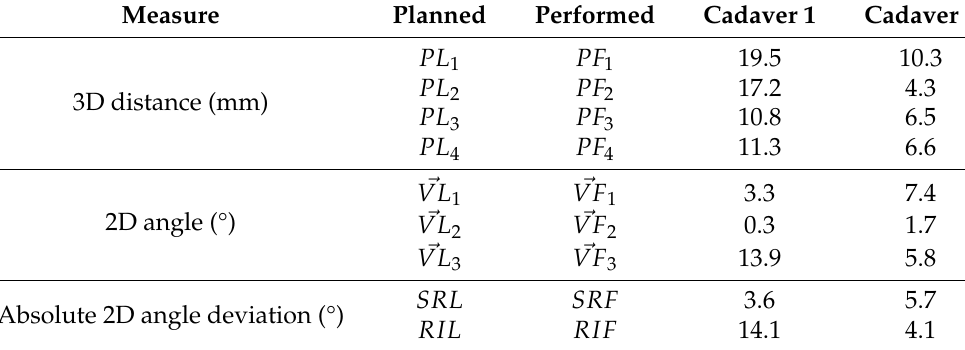
Table 1. Results of the AR guided osteotomies.